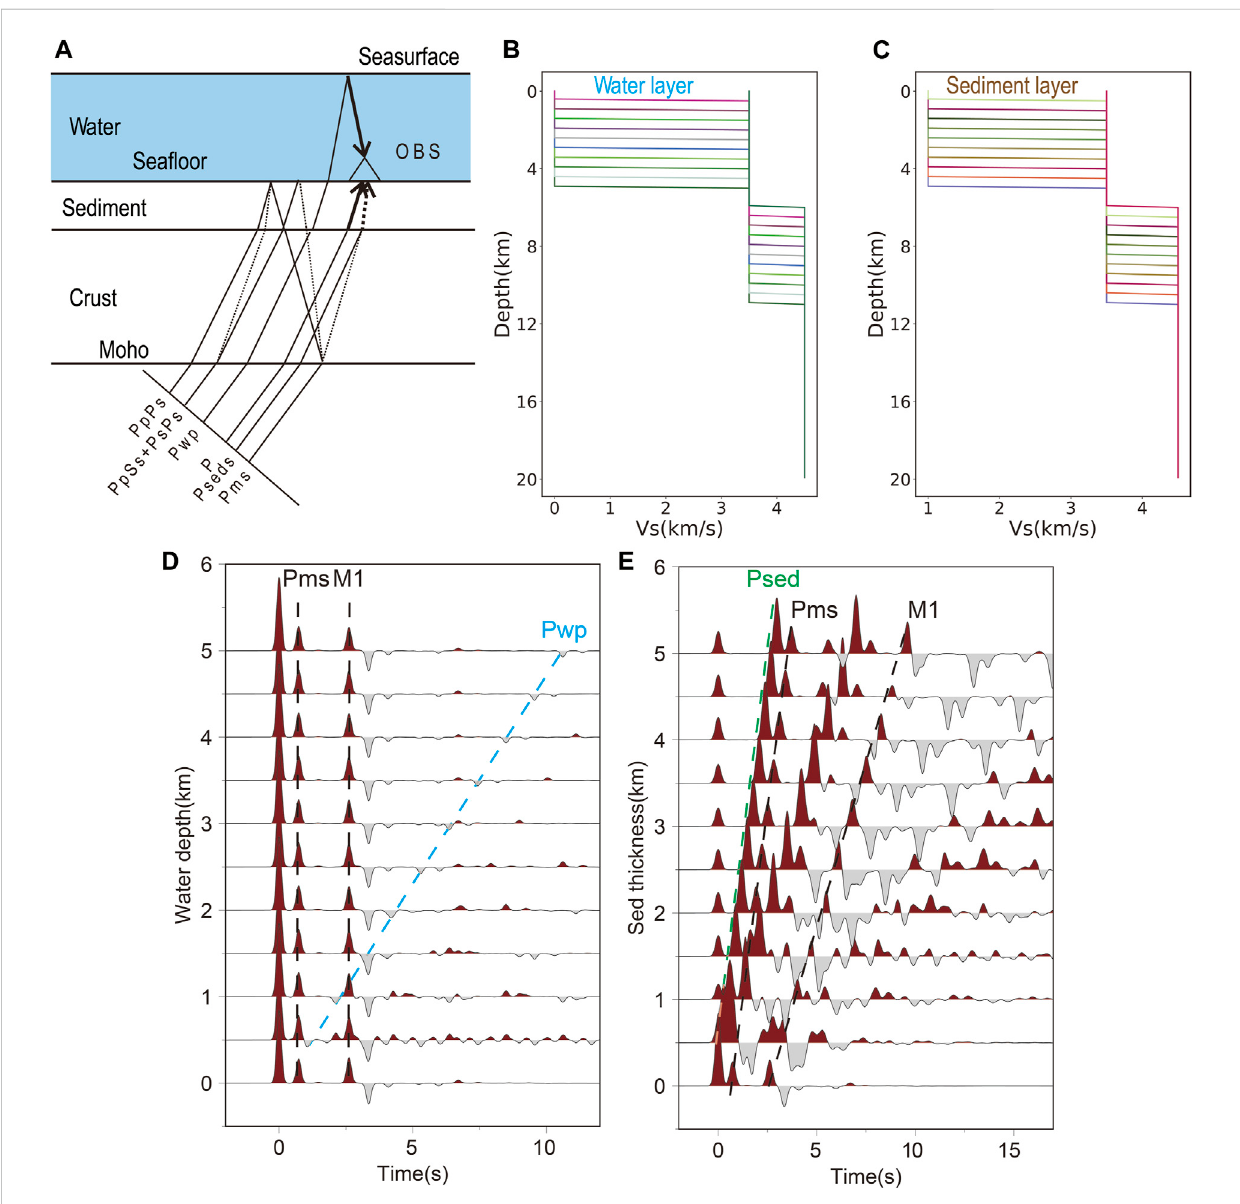
FIGURE 2 (A) The model with sediments and water layer. (B) The models with different water depth. (C) The models with different sediment thicknesses. (D) Synthetic receiver function of water model. (E) Synthetic receiver function of sediment